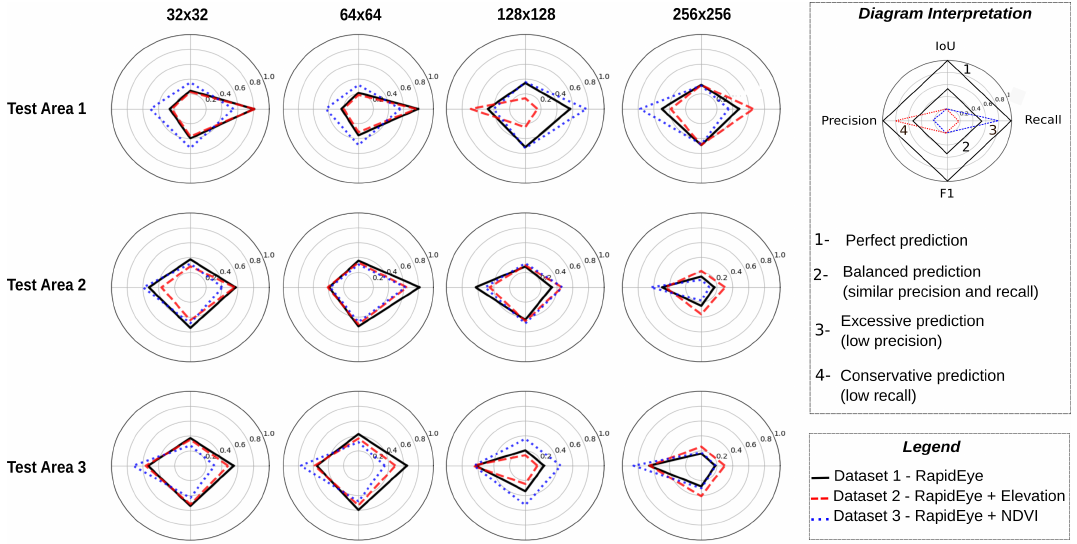
Figure 6. F1 score, precision, recall, and mIoU results of the best segmentation models trained with different patch